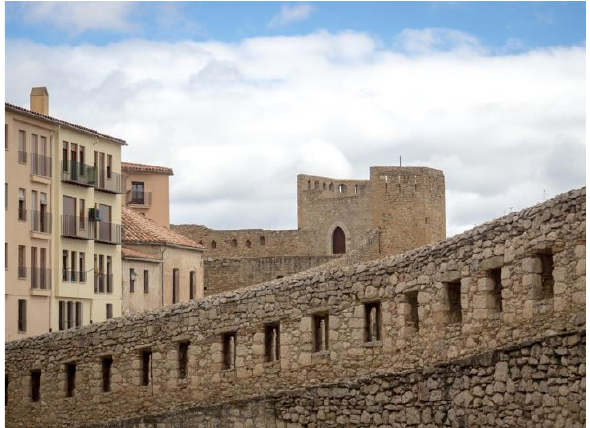
Figure 11. Section of the wall, with Torre Beneito in the background (Source: S. Portela, 2018).